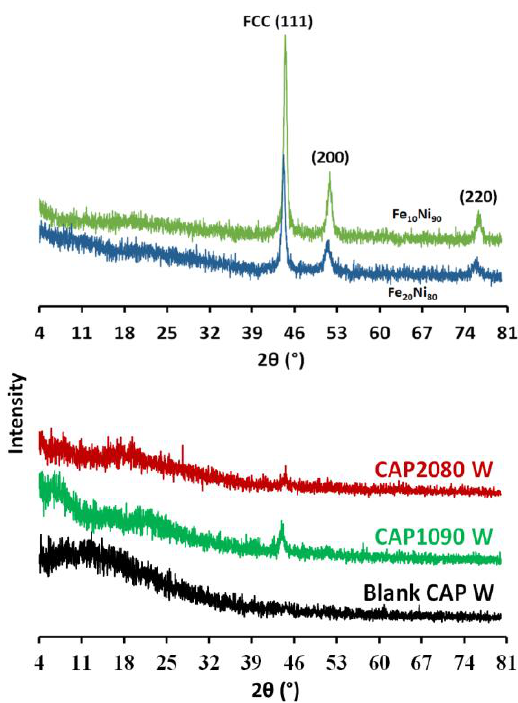
Figure 8. XRD analysis of the magnetic iron – nickel alloys used as fillers, the blank cellulose acetate (CA), and the magnetic mixed CA matrix membranes with 0.1 wt.% of lithium chloride used in the membrane dope.